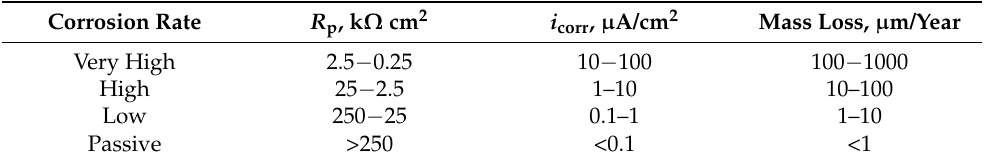
Table 1. Evaluation of corrosion rate of carbon steel in concrete [65]. Reproduced with permission from Millard, S. et al., NDT E Int.; Published by Elsevier, 2001. Corrosion Rate